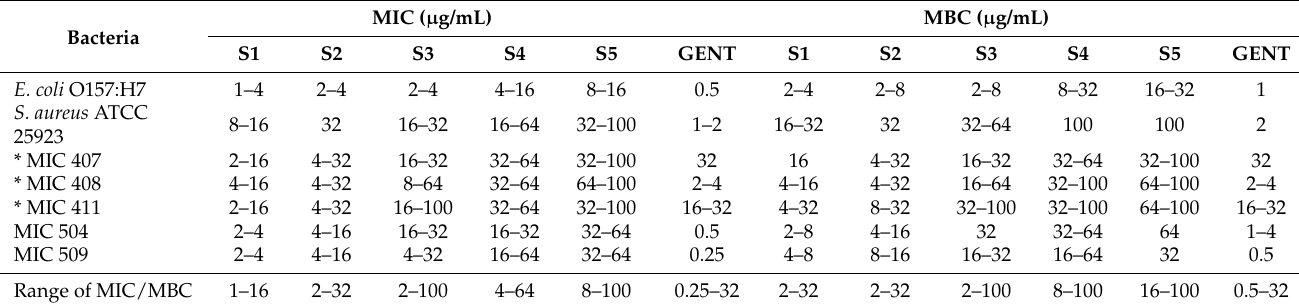
Figure 1. Characterization of AgNPs produced by chemical synthesis. ( a ) AgNP solution (S1–S5), ( b ) UV-Vis absorption spectrum of solutions containing AgNPs and ( c ) TEM image of AgNPs (scale 50 nm). The table for particle size distribution was produced using Image J software. Table 2. Minimum inhibitory concentration (MIC) and minimum bactericidal concentration (MBC) of AgNPs against bacteria by serial dilution plate count